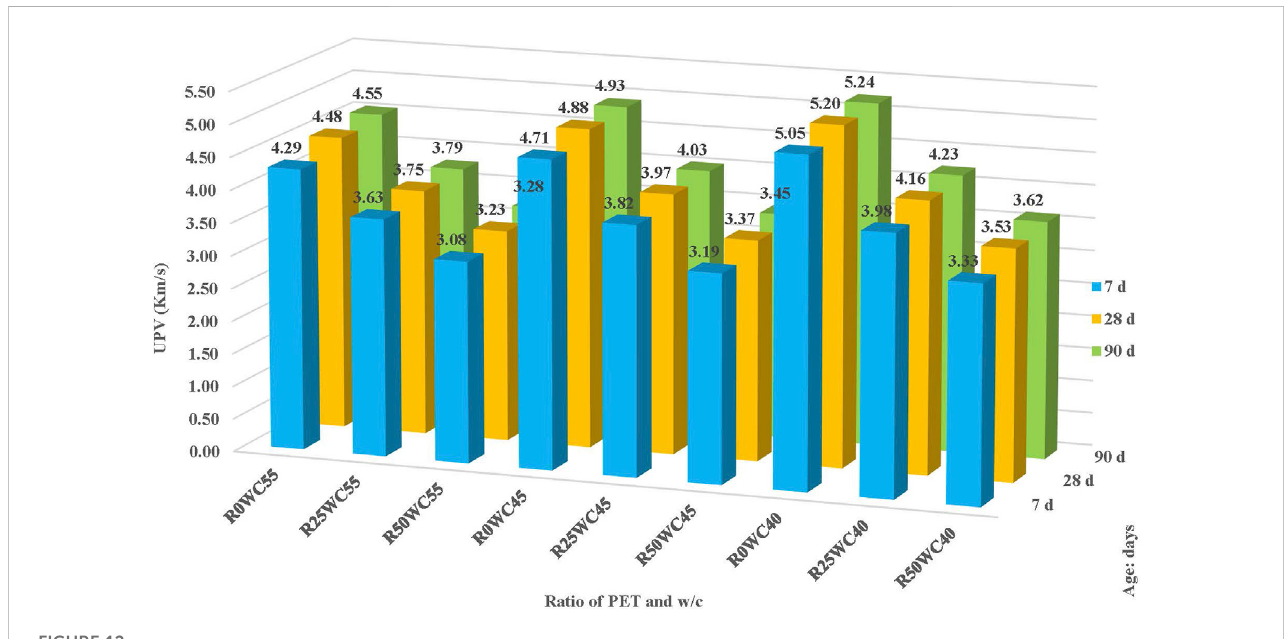
FIGURE 12 UPV test results.